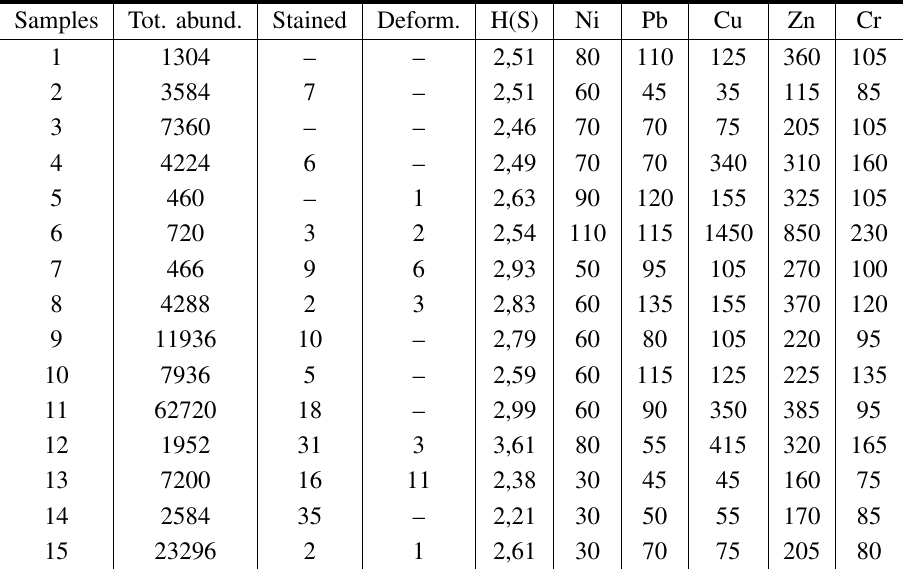
Total abundance of benthic foraminifera per sample, stained and deformed specimens, Shannon-Wiener H(S) diversity, and heavy metal results